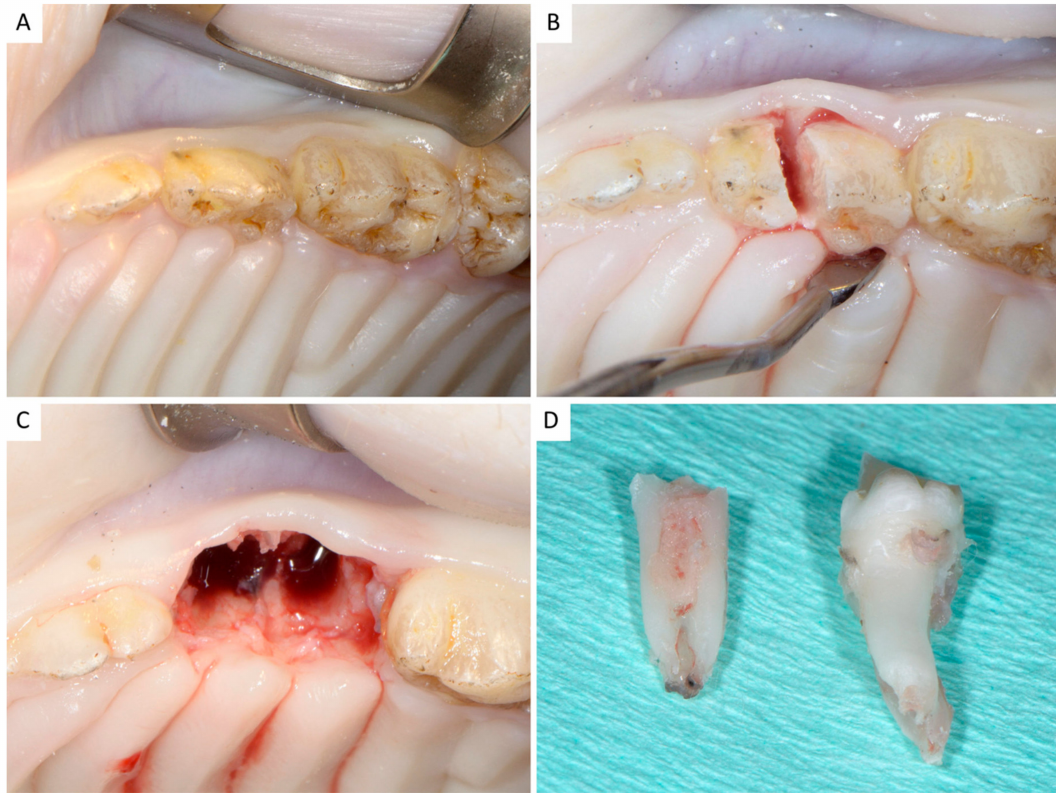
Figure 1. ( A ) Initial clinical view; ( B ) The deciduous maxillary second molar was sectioned, and each root was separately mobilized and extracted; ( C ) Clinical view of the site immediately after extraction; ( D ) The extracted